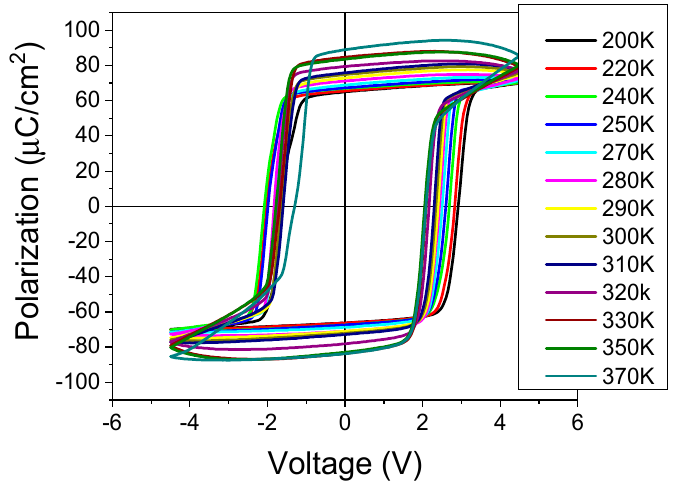
Figure 1. The hysteresis measurements performed between 200 K and 370 K at 1 kHz frequency and 5 V amplitude for epitaxial thin film PZT/SRO/STO.